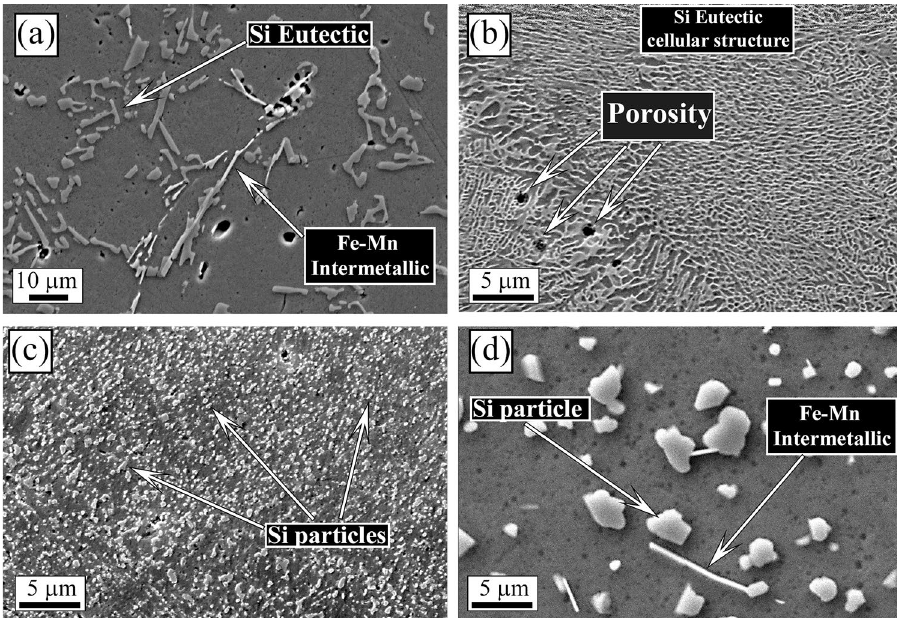
Figure 2. Scanning electron microscope (SEM) images, secondary electron mode, of the cast sample ( a ), as printed sample ( b ), annealed sample ( c ), solution treated sample ( d ) after etching with Graff-Sargent etching